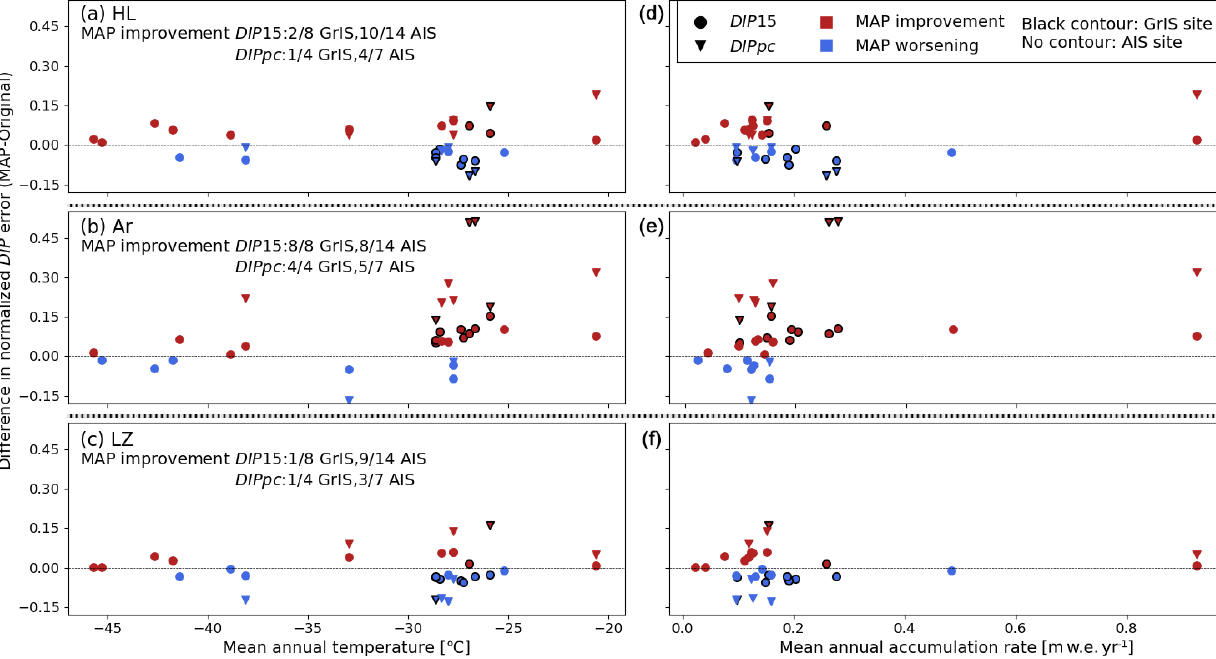
Figure 6. Improvements of the MAP models with respect to the original models for the evaluation data. The ratios indicate the ratios of cores for which an improvement is achieved by the corresponding MAP. Panels (a) – (c) display the mean annual temperature on the x axis and panels (d) – (f) display the mean annual accumulation